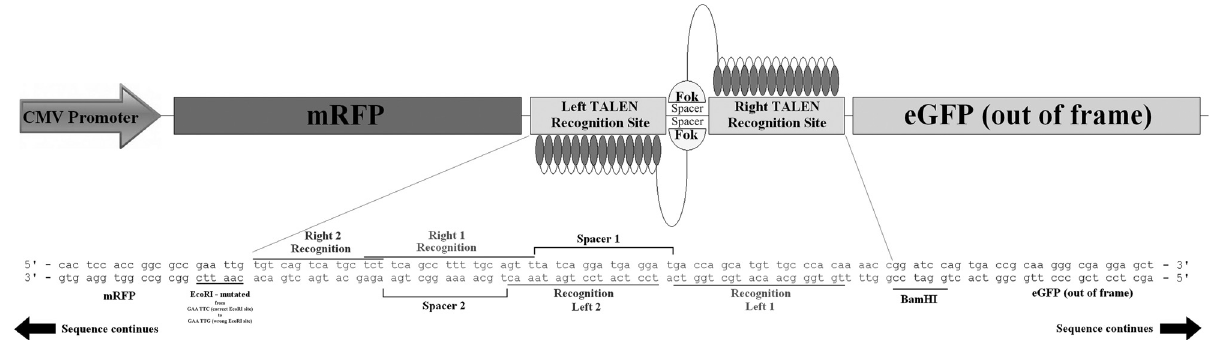
Figure 2 - Structure of the reporter plasmid pRGS-CR. A 66-bp sequence encoding both TALEN targets was inserted between red fluorescent protein (RFP) and green fluorescent protein (GFP) fused genes in plasmid pRGS-CR. Whenever TALEN is expressed upon transfection it digests the TALEN targetpresentinthereporterplasmidandthenon-homologousendjoining(NHEJ)repairsystemofthecellcanmakerandomdeletionsorinsertionstore- store the eGFP reading frame (Kim et al. ,